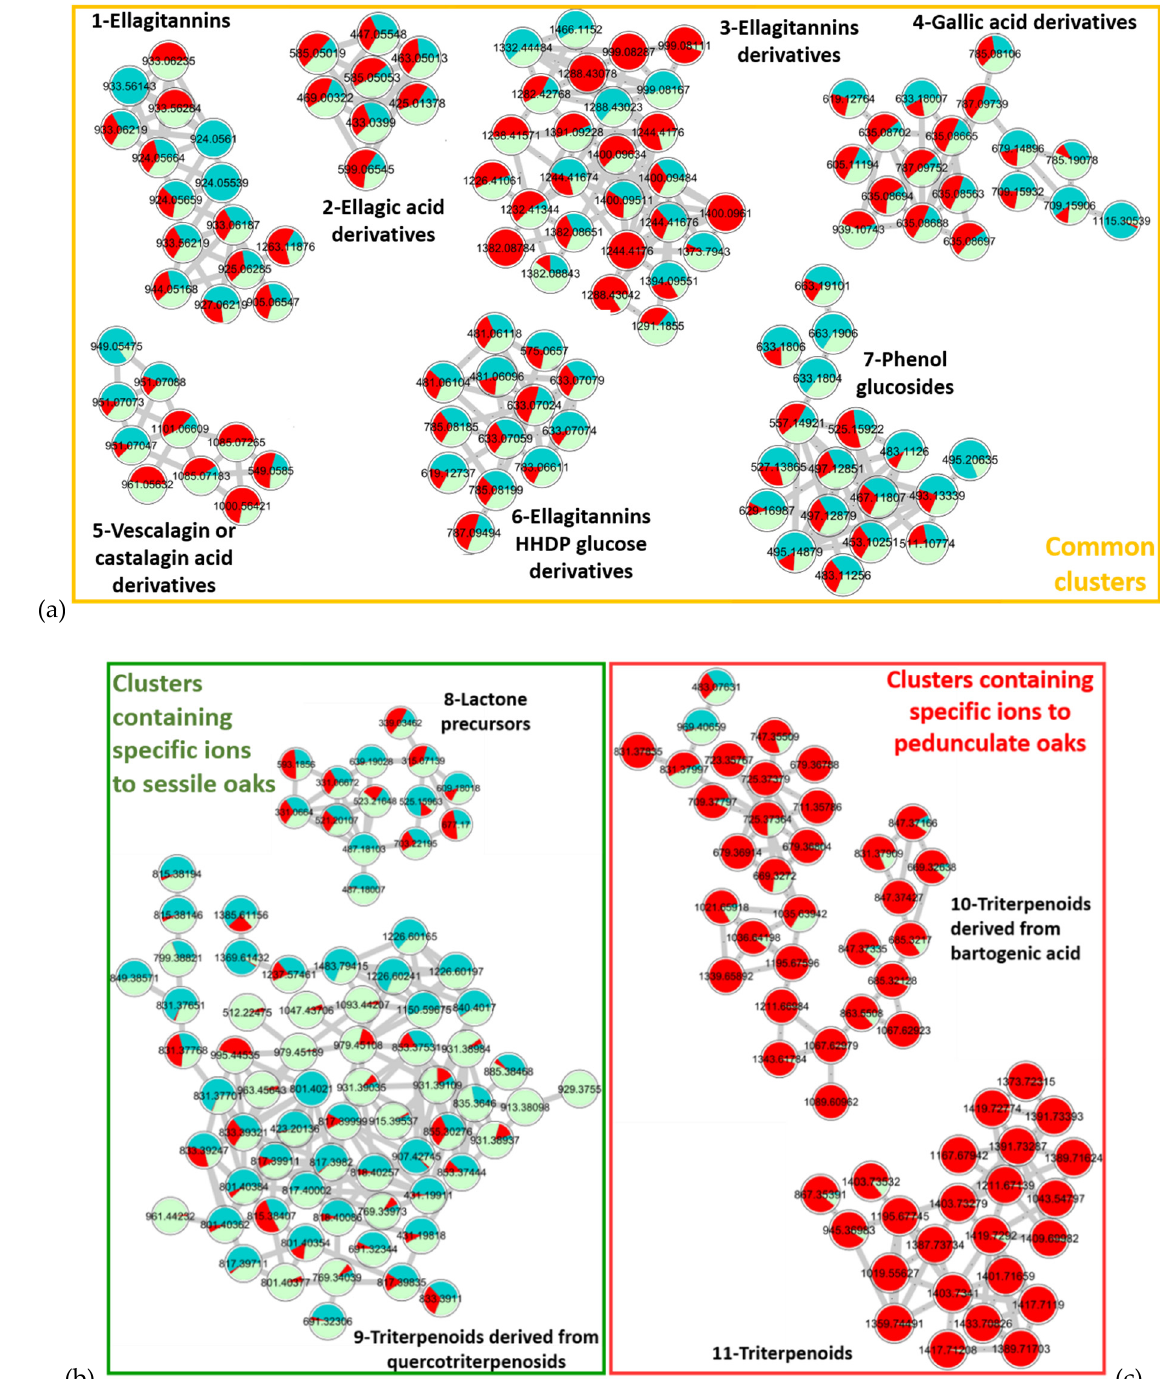
Figure 6. Molecular network representing the distribution of an individual (1 sample) of sessile oak (blue) compared to the pool (21 samples) of sessile (green) and (21 samples) pedunculate (red) oaks with cos 0.75 and matched fragment 6 parameters. ( a ) Clusters 1–7 representing common clusters shared between sessile, pedunculated and unknown individual, ( b ) Clusters 8 and 9 containing specific ions to sessile oaks shared with unknown individual and ( c ) Clusters 10 and 11 containing specific ions to pedunculated oaks.